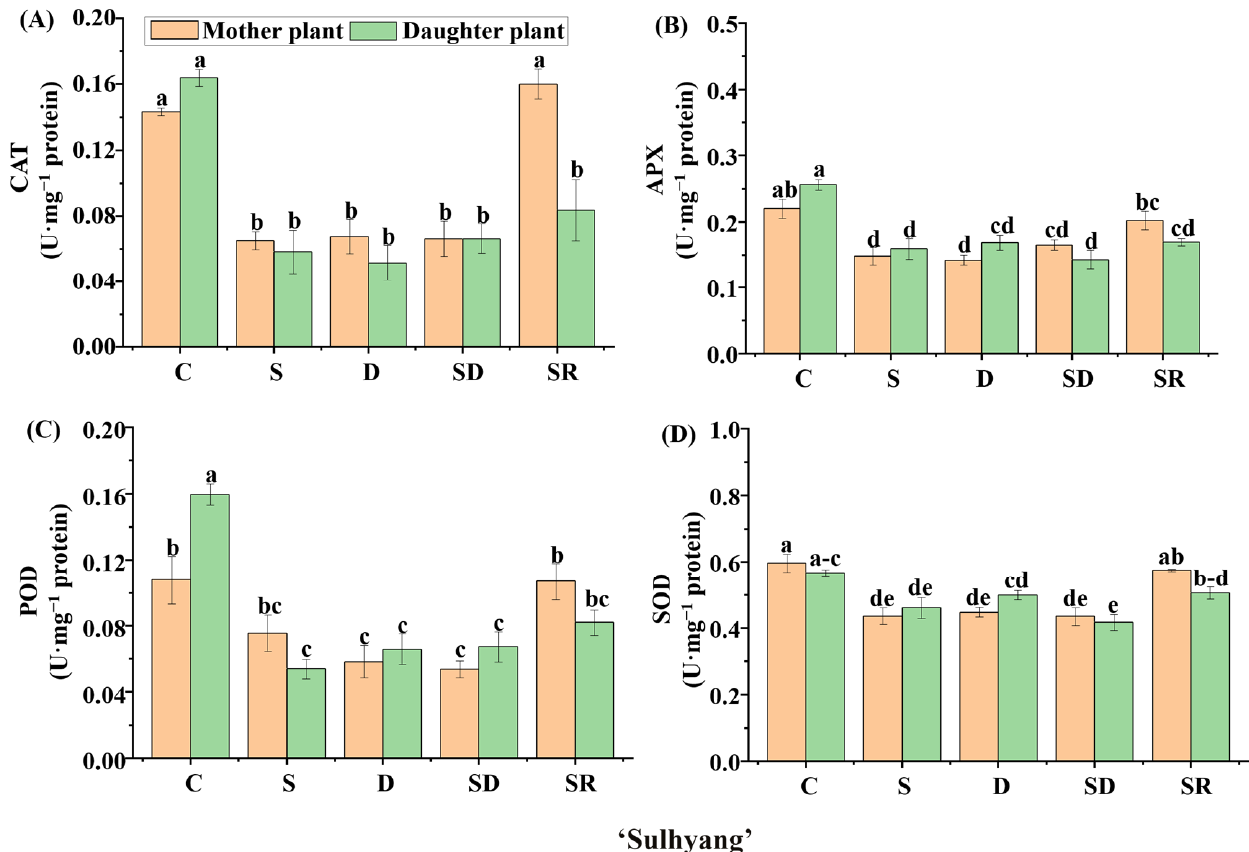
Figure 8. The activities of catalase (CAT) ( A ), ascorbate peroxidase (APX) ( B ), guaiacol peroxidase (POD) ( C ), and superoxide dismutase (SOD) ( D ) in ‘Sulhyang’ as affected by the Si treatments. Lowercase letters indicate significant differences calculated by the Duncan’s multiple range test at p ≤ 0.05: C, control; S, sprayed “mother” plant; D, drenched “mother” plant; SD, dressed “mother” plant; and SR, sprayed “daughter” plant.